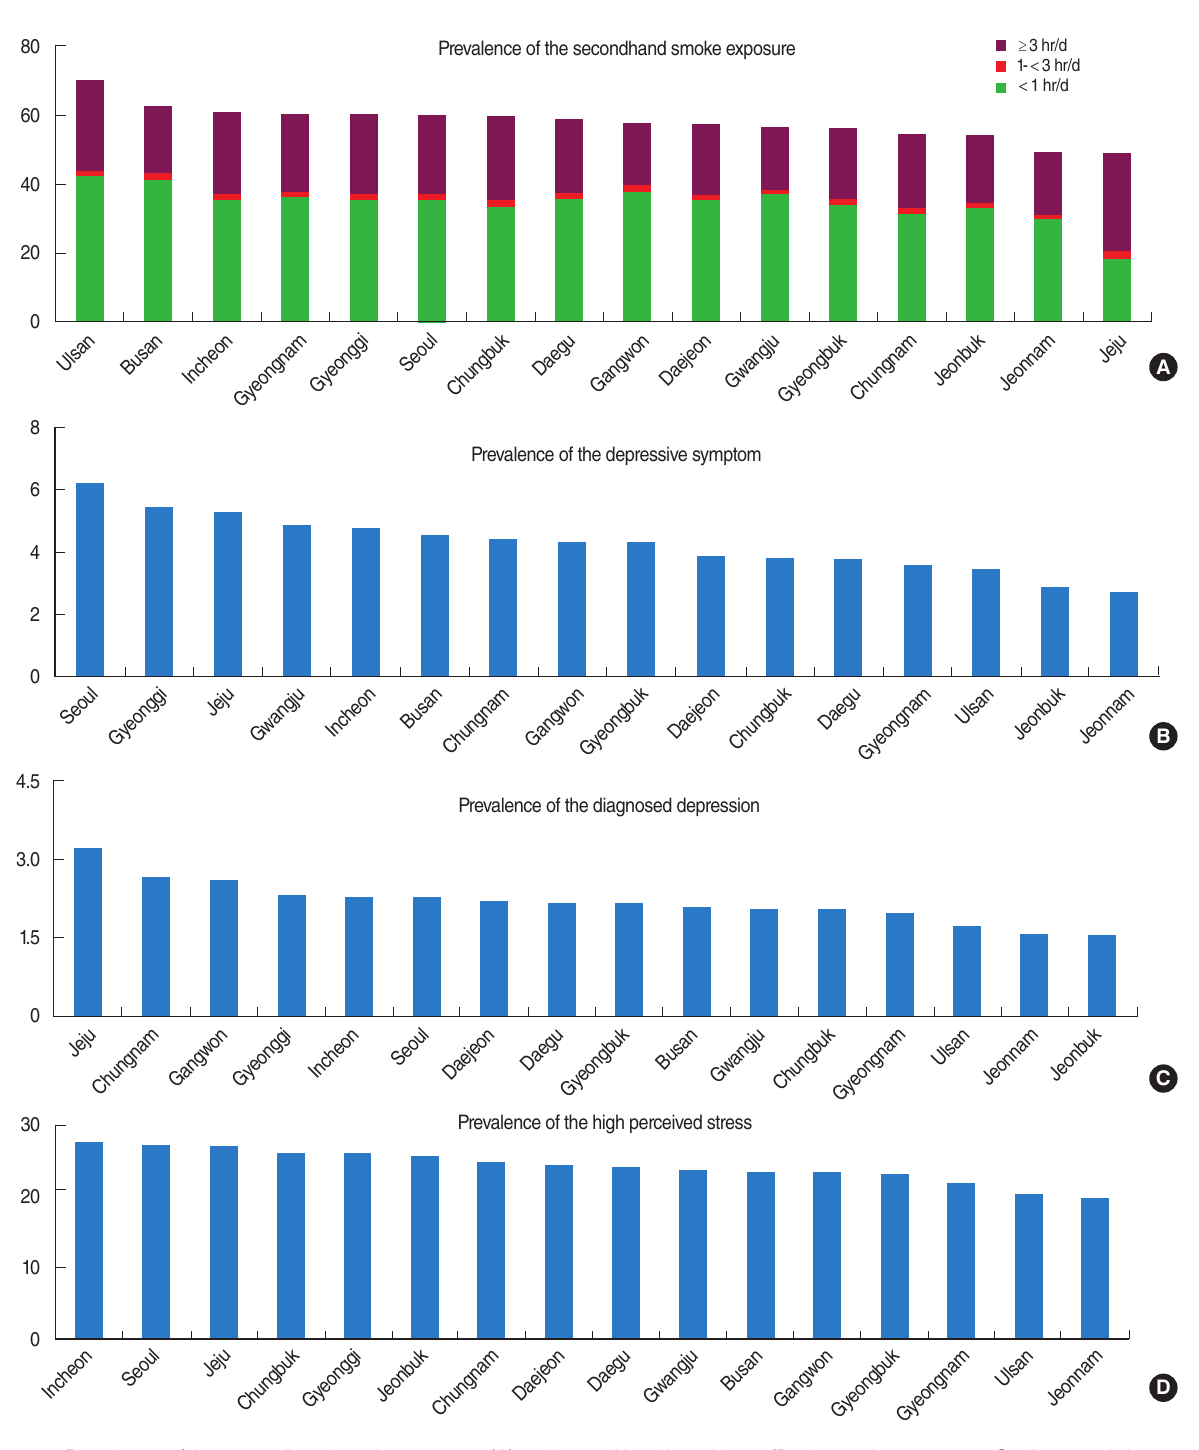
Figure 1. Prevalence of the secondhand smoke exposure (A) and mental health problems (B: depressive symptom, C: diagnosed depres- sion, and D: high perceived stress) by